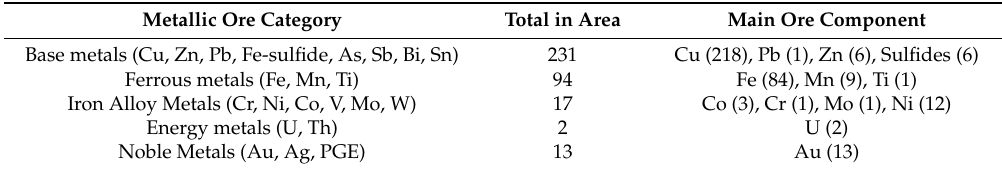
Table 1. Metallic ore deposits in the studied Finnmark region (according to NGU’s